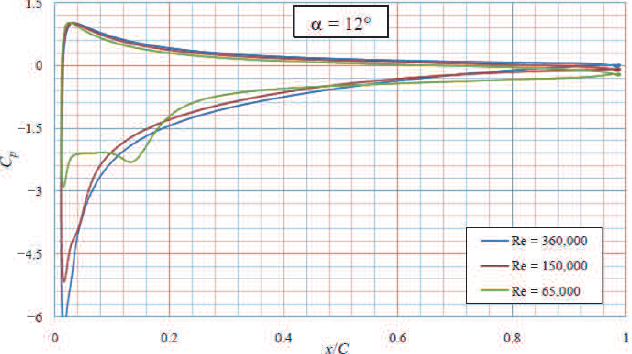
Figure 26. Pressure coefficient along airfoil as a function of distance from leading edge for α = 12 ◦ .